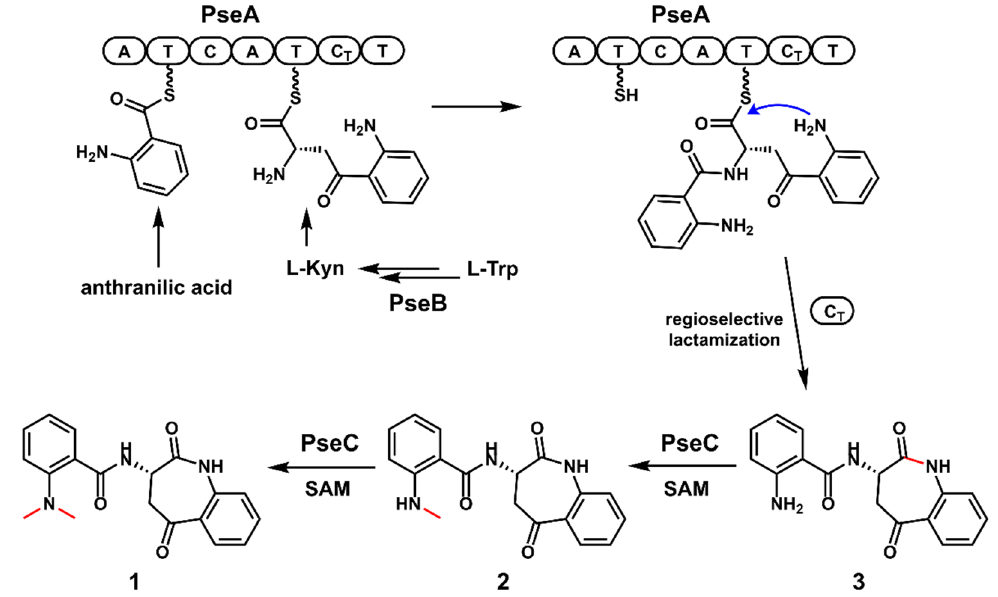
Figure 4. The proposed biosynthetic pathway of pseudofisnins.